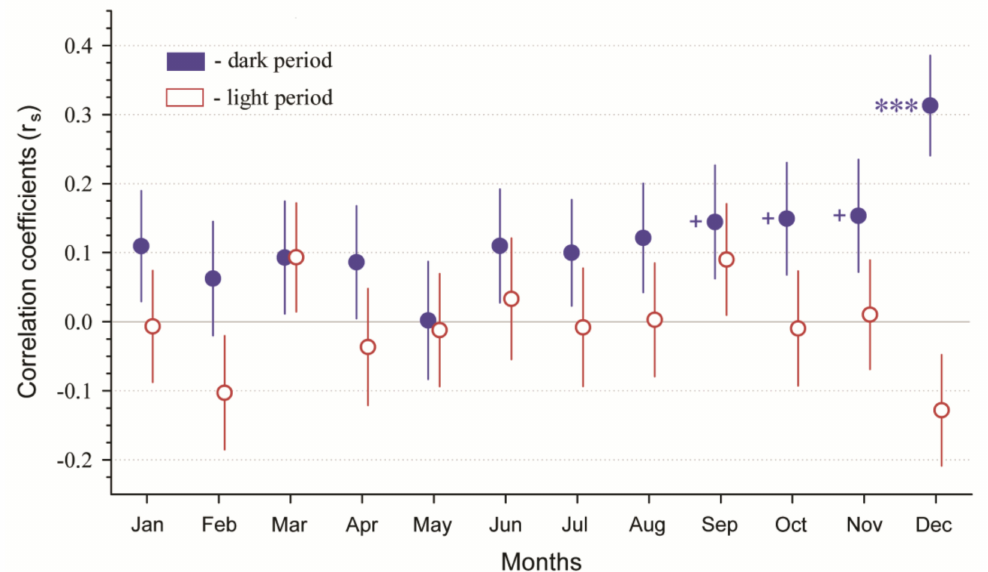
Figure 3. Spearman’s correlation coefficients between wildlife–vehicle collisions (WVCs) and lunar disk percentages (LDPs) during 2014–2018 in Lithuania. Closed circles indicate correlation coefficients between WVCs and LPD that occurred during the dark period (night), while open circles indicate correlation coefficients between WVCs and LDP during the light period (day). Whiskers indicate Std. errors based on 10,000 bootstrap replicates. *** indicates p < 0.001, and + indicates one-tailed significance; p <